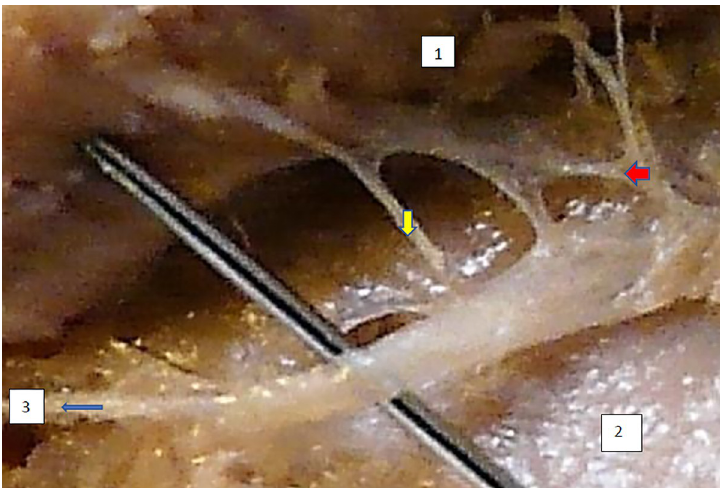
Fig 12. Superior gluteal nerve, bushy type, horizontal course, morphological age 113–17–V, v–tub 110,V–pl 140, mass 120, male sex, magnification 50x 1–gluteus medius muscle, 2–gluteus minimus muscle, 3–tensor fasciae latae muscle, red arrow–branch to gluteus medius muscle, yellow arrow–branch to gluteus minimus muscle, blue arrow–branch to tensor fasiae latae muscle.